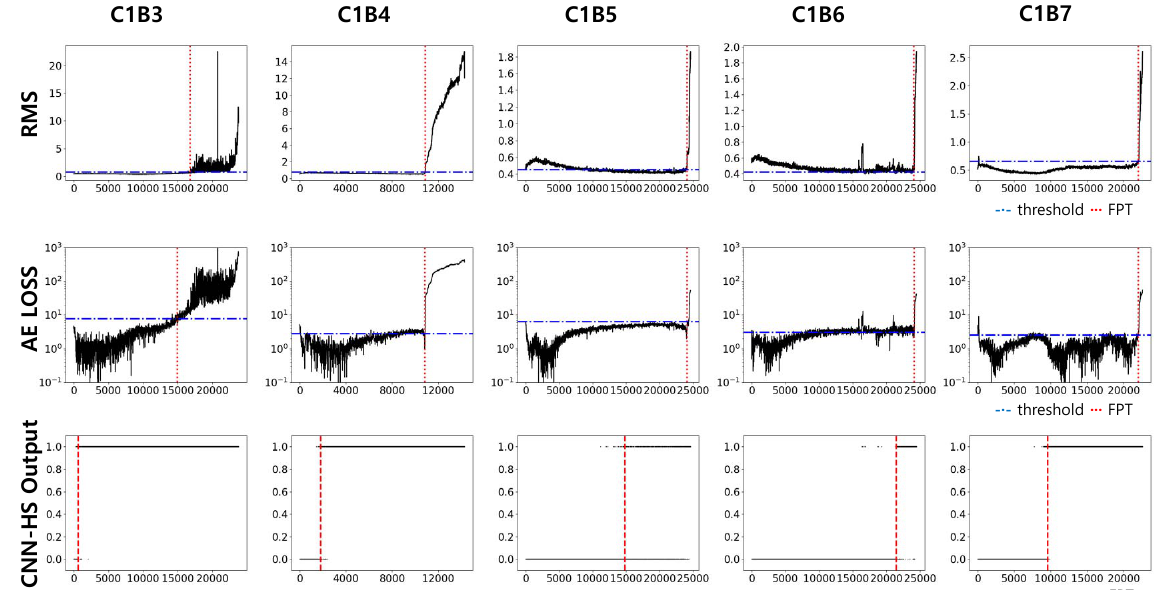
Figure 9. Predicted FPT using RMS, AE, and CNN-HS on FEMTO dataset (condition C1).